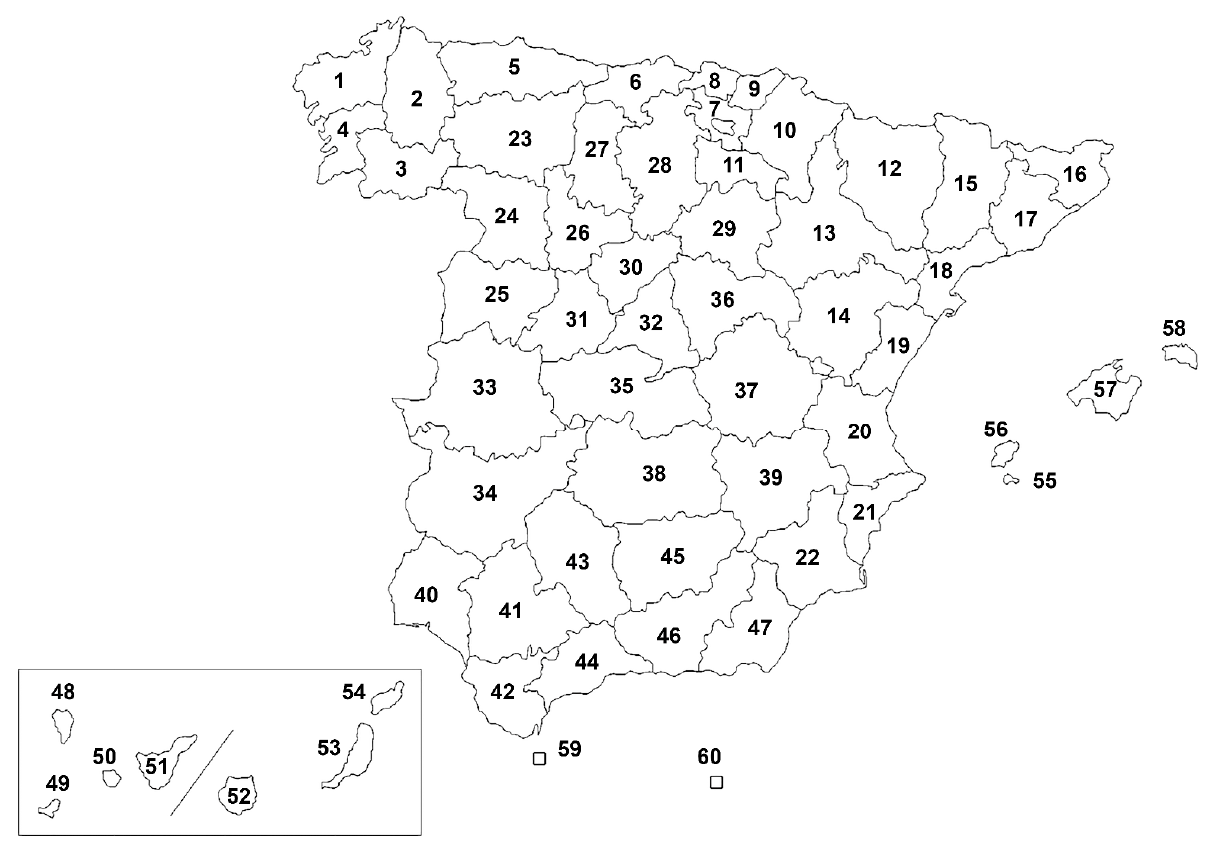
Figure 1. Provinces, islands and autonomous cities of Spain tested in this study. The numbers correspond to the provinces, islands and autonomous cities described in Table 1.